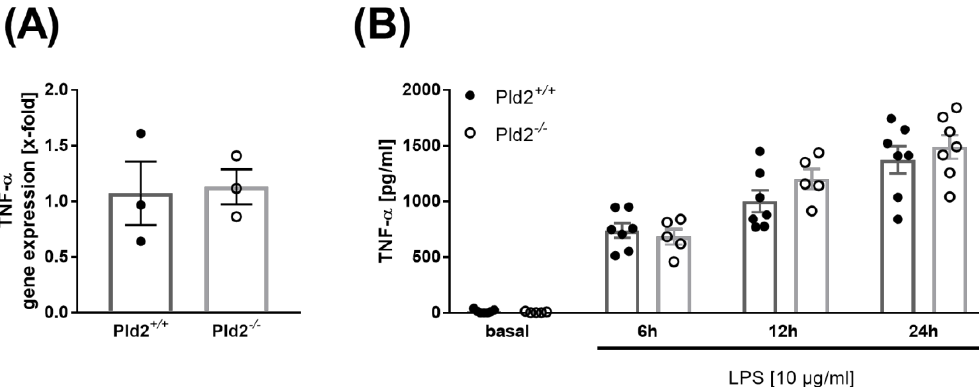
Figure 3. PLD2 does not regulate TNF- α expression and release. ( A ) TNF- α expression in the left ventricle of Pld2 +/+ and Pld2 -/- mice 24 h after I/R was quantified by quantitative RT-PCR, n = 3. (B) Monocytes from whole blood of Pld2 +/+ and Pld2 -/- mice were isolated and stimulated with lipopolysaccharide (LPS) to analyze TNF- α release at different time points, n = 3. Bar graphs depict mean values ± SEM. Statistical analysis was performed using two-tailed Student’s t -test.